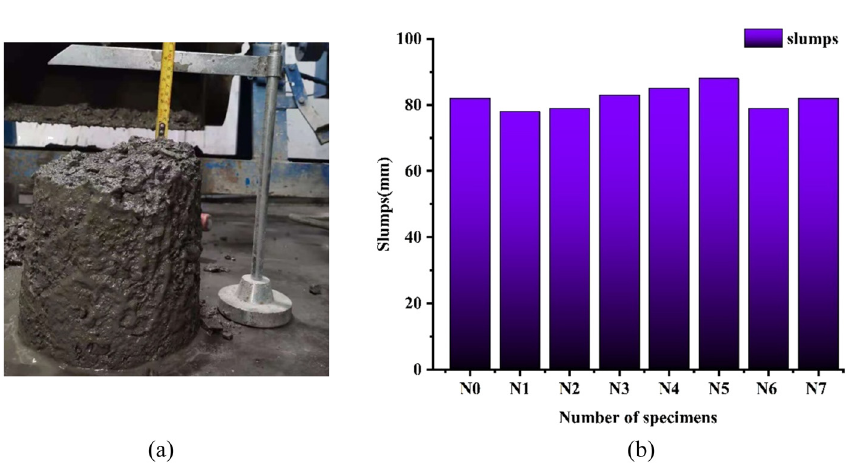
Figure 2: Performance of concrete. ( a ) Slump test. ( b ) The slump of concrete in each